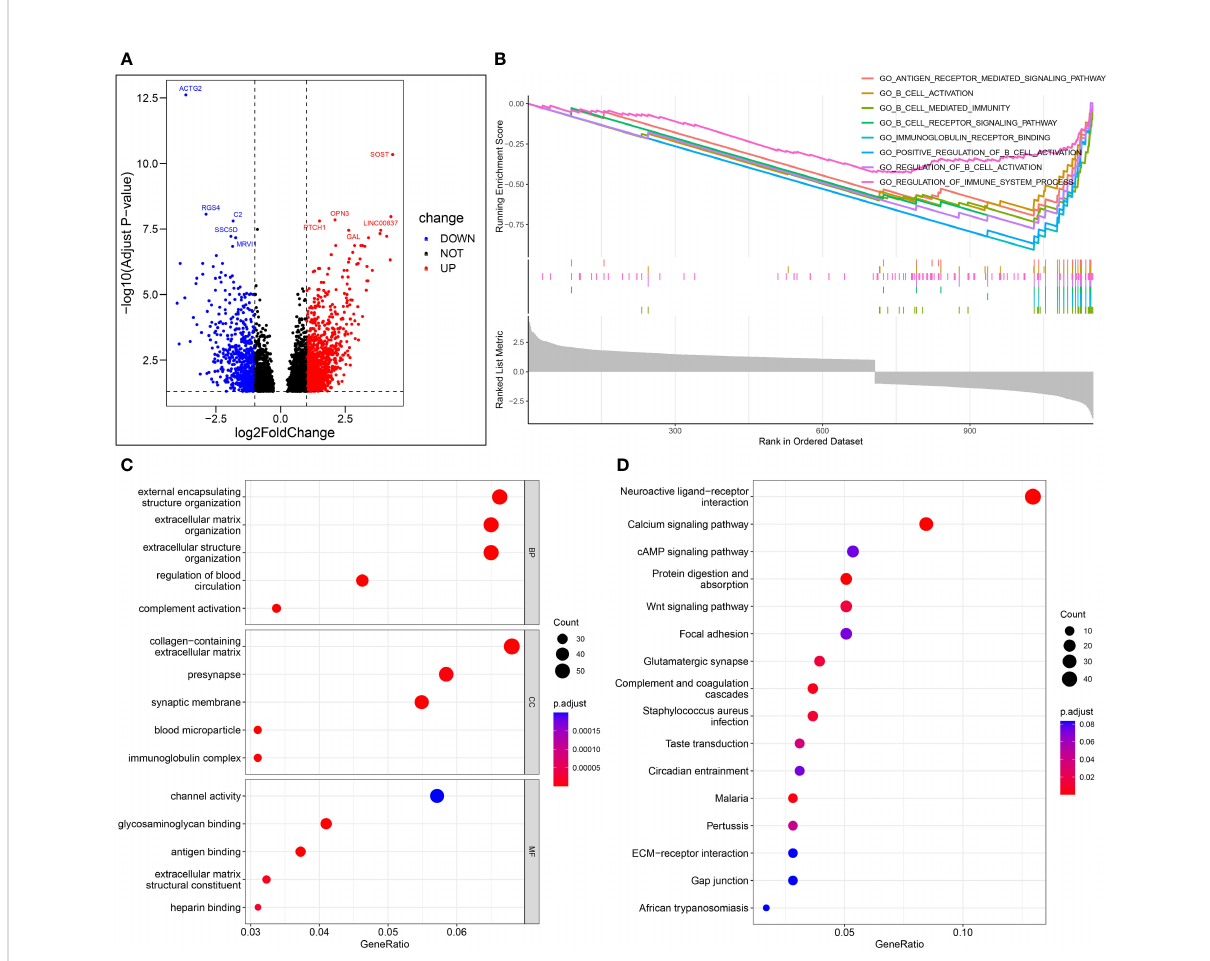
FIGURE 9 Enrichment analysis. (A) Volcano map of differential genes in the high-risk and low-risk groups. (B) The important pathway of GSEA analysis. (C) The most signi fi cant and shared KEGG analysis in the TCGA. (D) The most signi fi cant and shared GO analysis in the